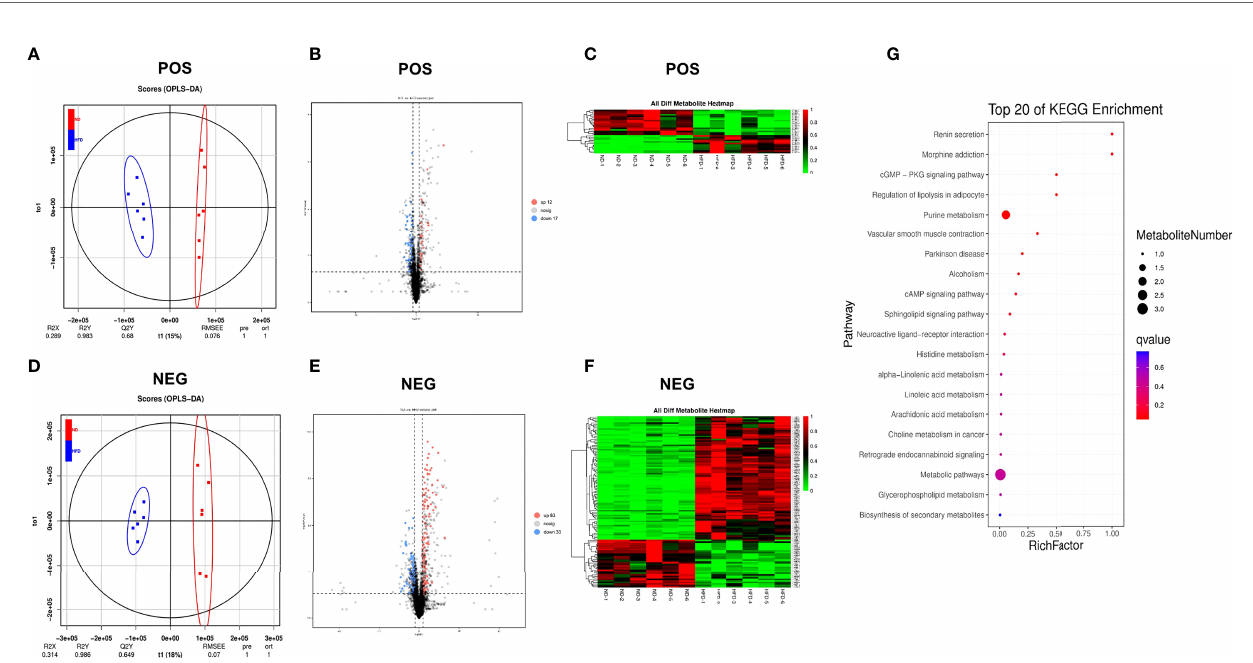
FIGURE 4 | High-fat diet changed the serum metabolome. (A, D) OPLS-DA scores plot of serum metabolite pro fi ling between the ND and HFD groups in both the positive and negative modes. (B, E) Volcano plot analysis of serum metabolites (VIP > 1,|P(corr)| > 0.5, jackknifed 95% con fi dence intervals). (C, F) Heat maps of serum metabolites of the two groups based on the linear transformation of the raw data (the interval of [0,1]). (G) The bubble diagram of the top 20 KEGG enriched